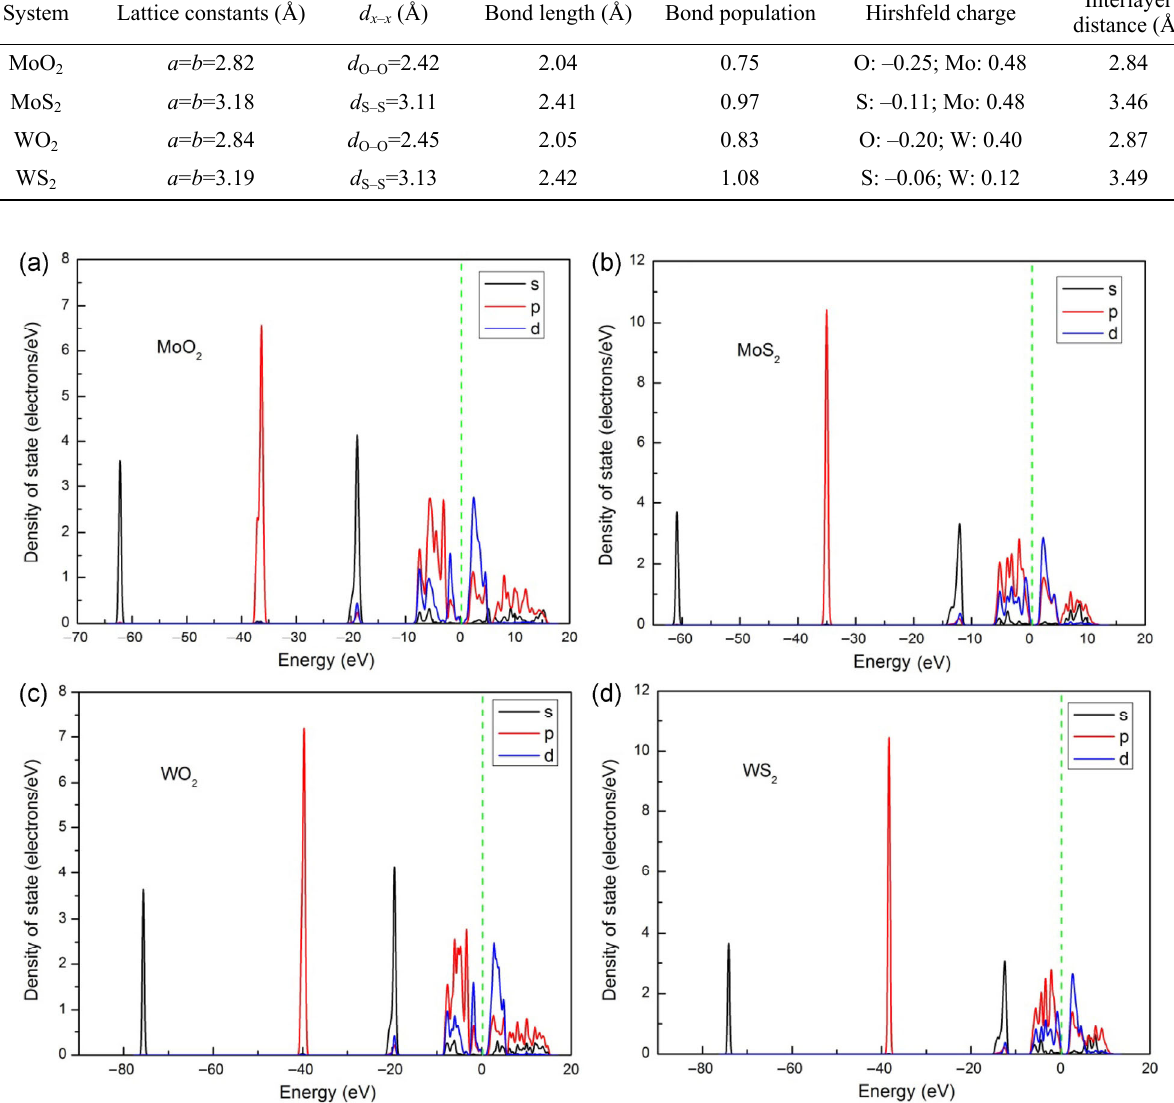
Fig. 3 Density of states distribution of single layer nanostructures of MoO 2 , MoS 2 , WO 2 , and WS 2